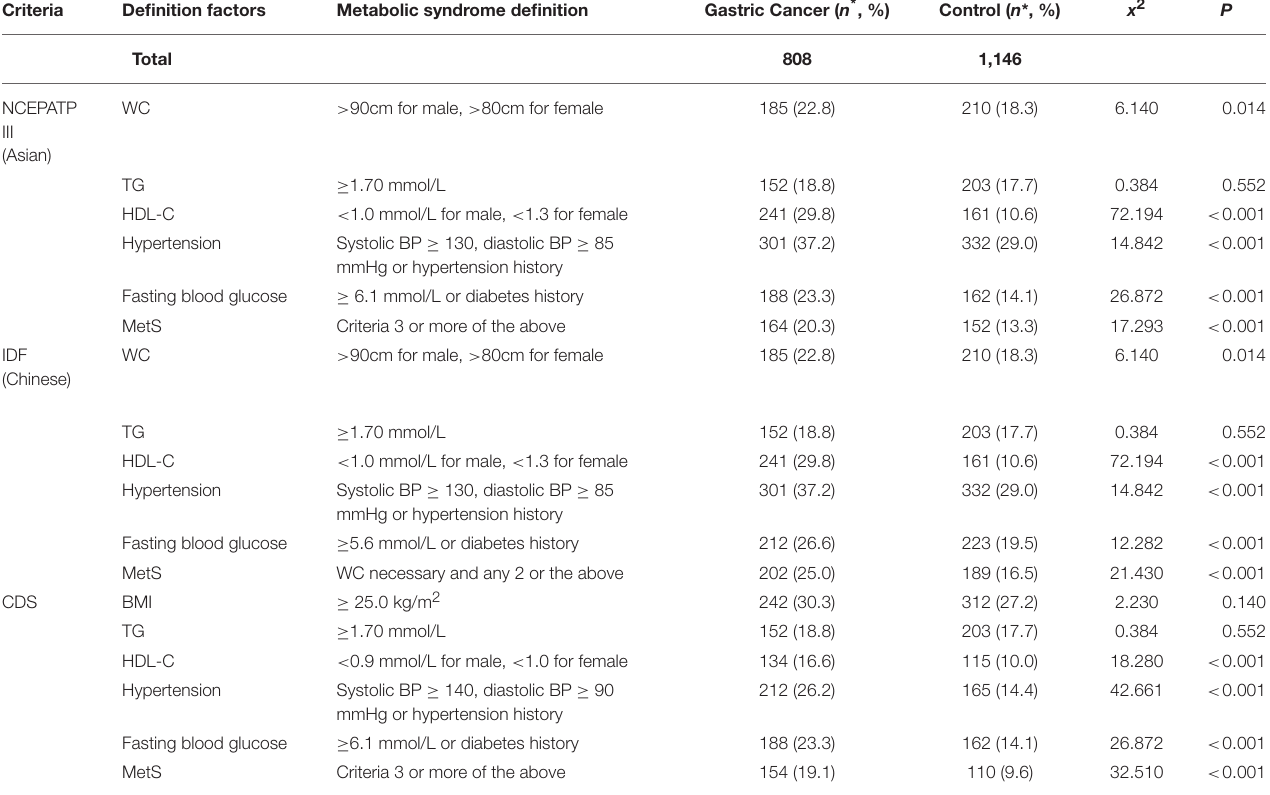
TABLE 2 | Proportion of metabolic syndrome according to three different